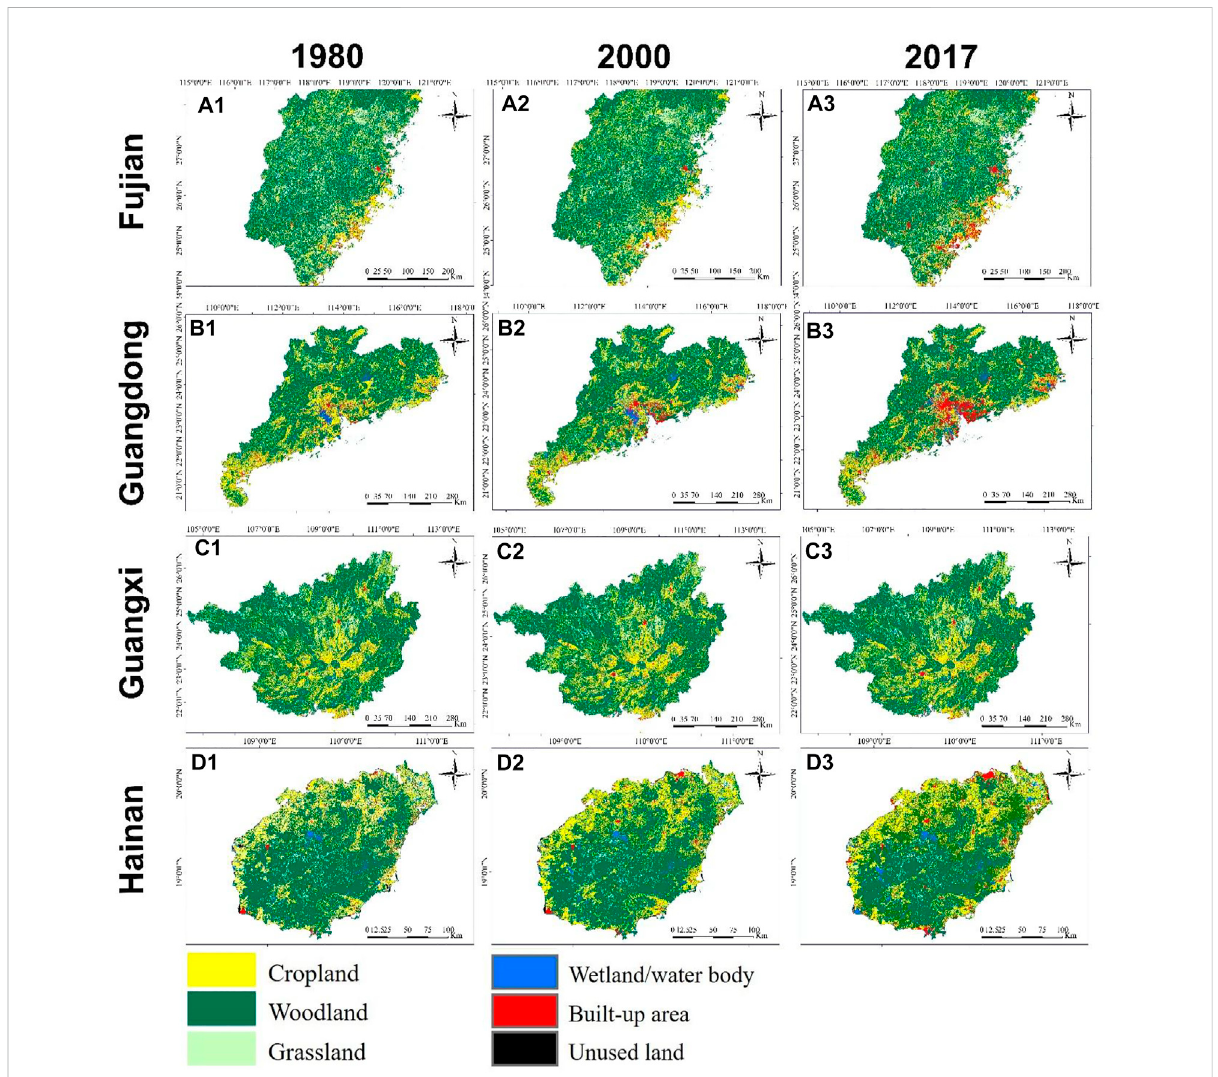
FIGURE 3 Spatial disparities of landscape composition for four provinces/region in the three periods of 1980, 2000, and 2017: (A) Fujian, (B) Guangdong, (C) Guangxi, and (D)